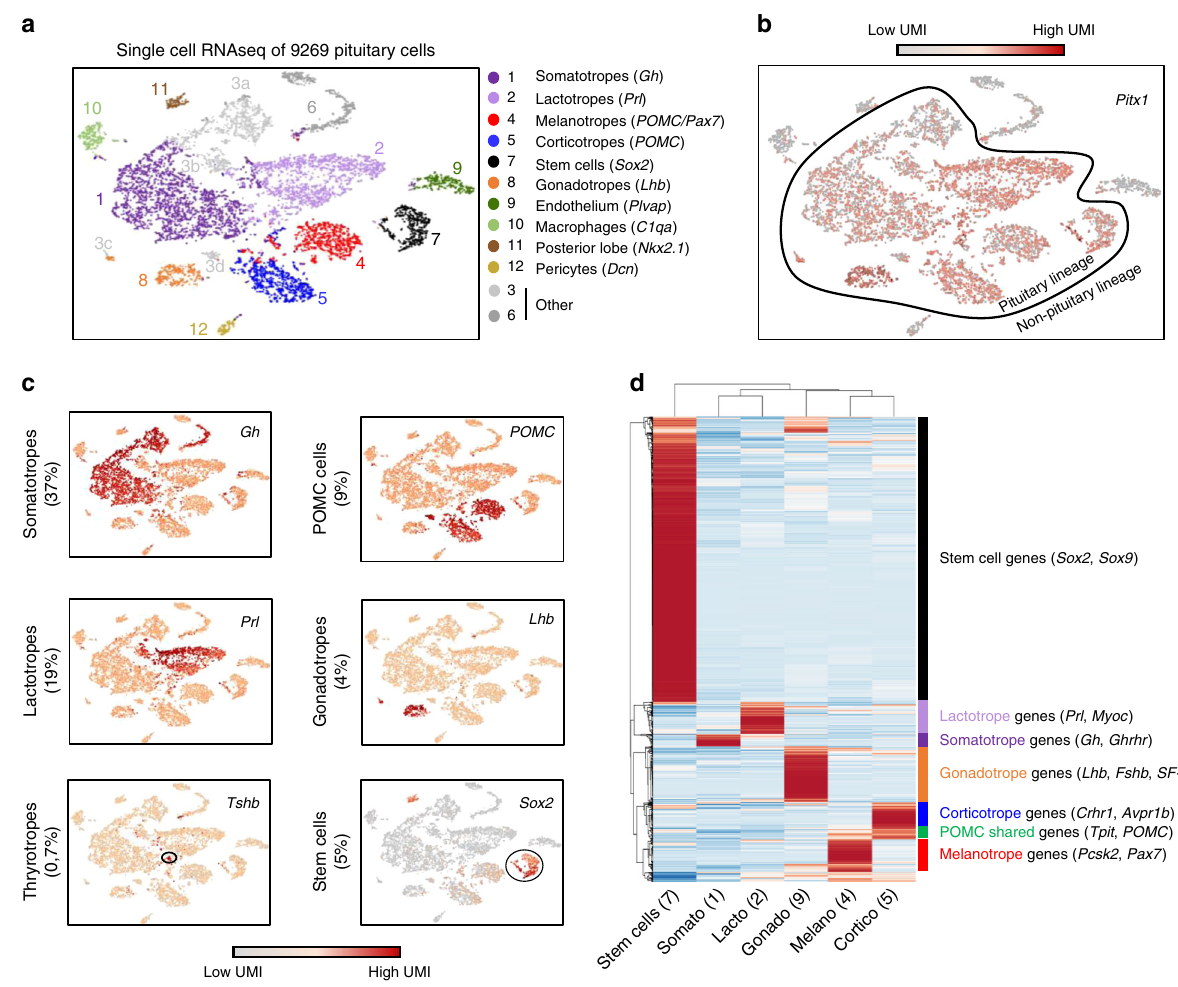
Fig. 1 Transcriptional complexity of the pituitary adult gland. a t-Distributed stochastic neighbor embedding (t-SNE) map (t-distributed stochastic neighbor embedding) plot of the 9269 pro fi led pituitary cells colored by the 12 clusters identi fi ed using unsupervised k -means clustering. Cluster identi fi cation included expression of the hallmarks gene(s) indicated between parenthesis and the markers shown in c . b t-SNE map showing color-coded Pitx1 expression. c t-SNE map showing color-coded expression of indicated markers for the major pituitary lineages. d Heatmap showing normalized expression of the 1000 most differentially expressed genes ( p value <0.05, fold change (FC) >2 and minimum number of unique molecular identi fi er (UMI) >0.3) in clusters representing the different endocrine and progenitor cells (clusters 1, 2, 4, 5, 7, and 8). Rows are centered; unit variance scaling is applied to rows. Both rows and columns are clustered using correlation distance and average 98926 open chromatin regions across the pituitary lineages (Fig.